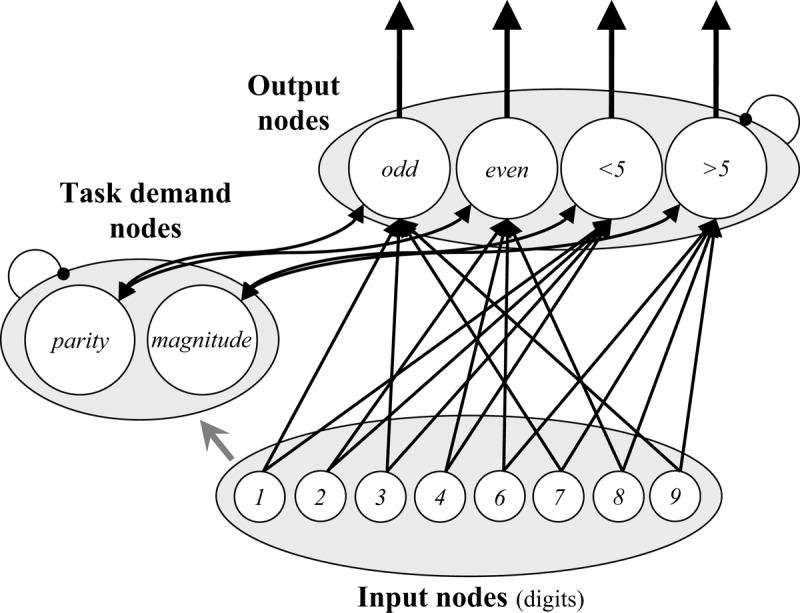
The Gilbert and Shallice (2002) model as it applies to cued task switching. All connections are hardwired. Notes: arrow = facilitative connection, circle = within-layer competition, grey arrow = all-to-all connections from stimuli to task demand nodes.